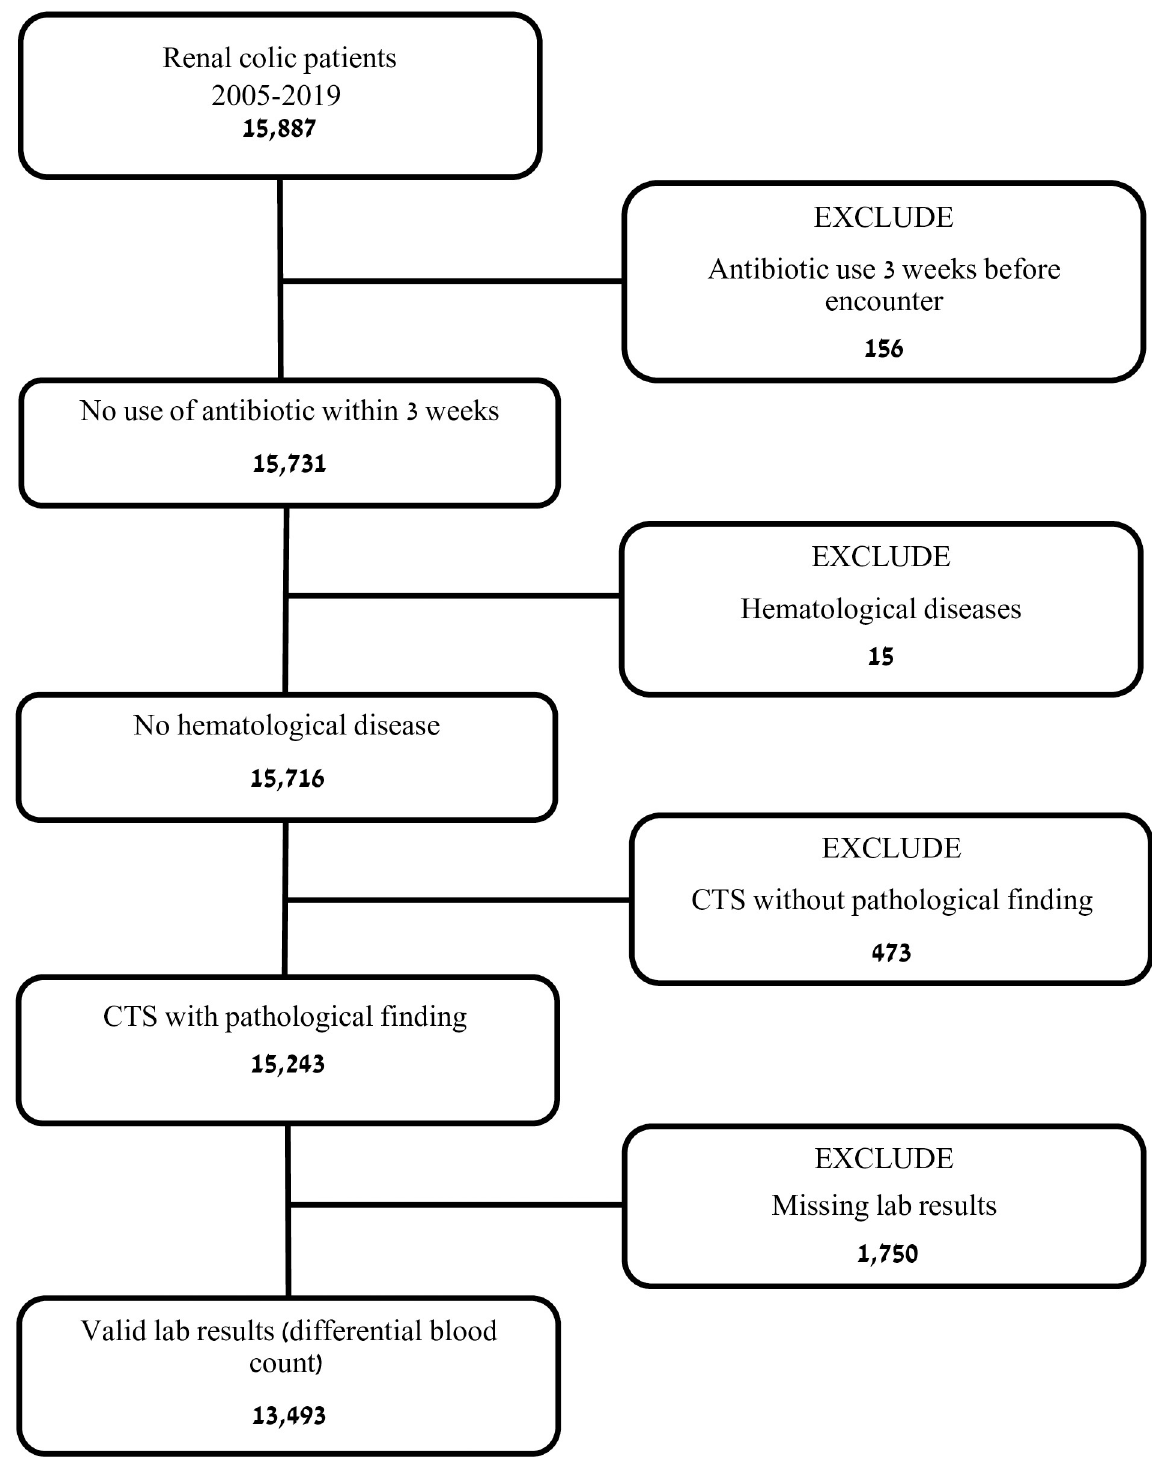
Fig 1. CONSORT flow diagram of renal colic study patients.